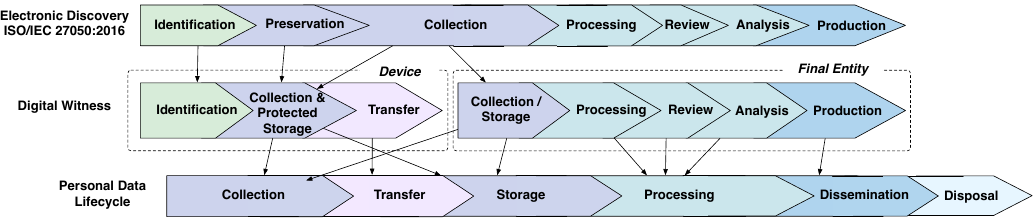
Figure 2. Data lifecycle and its relationship with ISO/IEC 27050:2016 and Digital